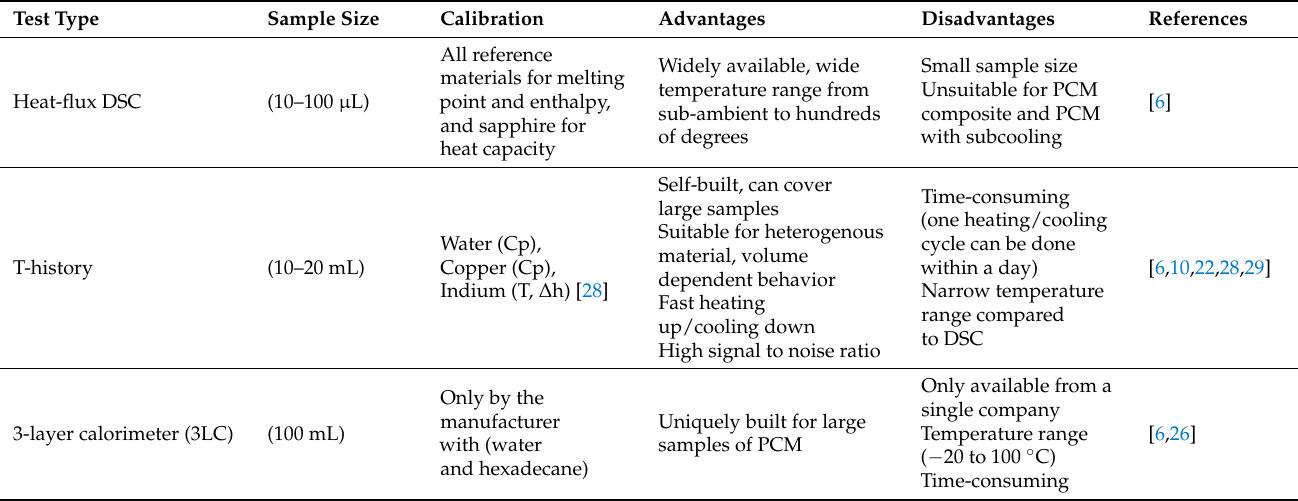
Table 2. Summary of the different calorimetric